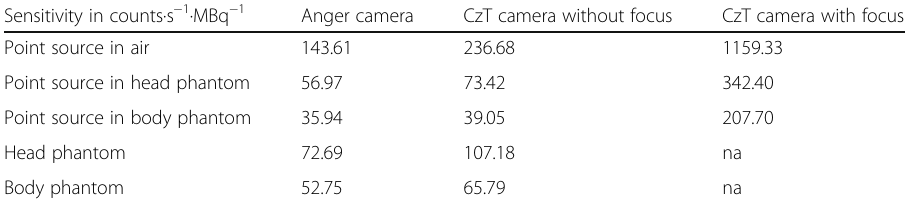
Table 2 Sensitivity measured with different source geometries on Anger and CzT cameras with and without focus